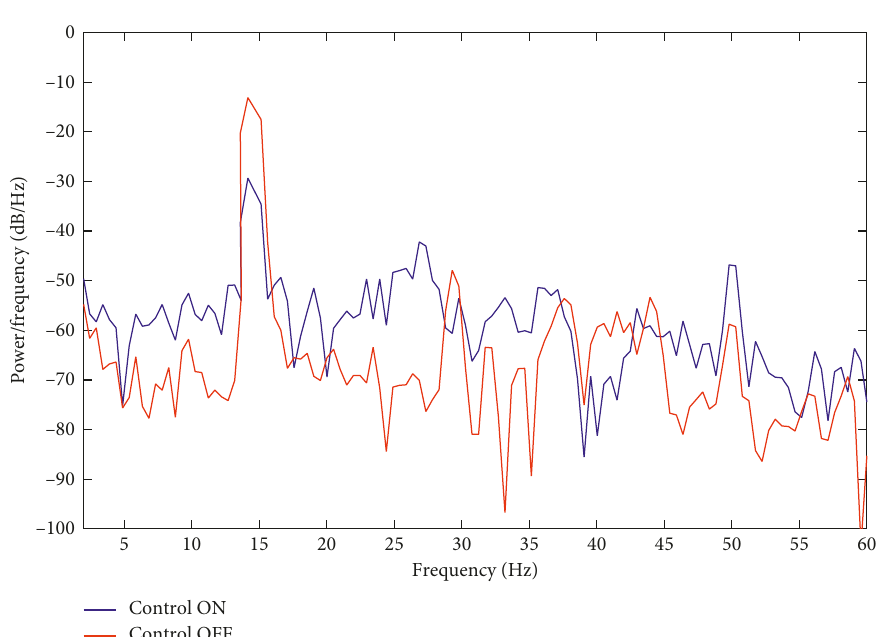
Figure 11: Comparison diagram of power spectrum with LQR control on/off.